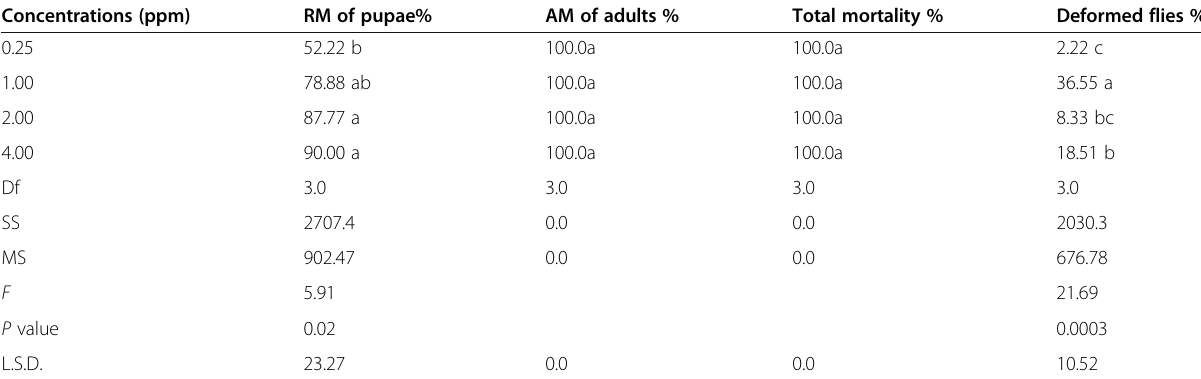
Table 2 The real and apparent mortalities, and deformed flies percentages of the peach fruit fly, Bactrocera zonata , treated with abamectin pesticide at pupal stage Concentrations (ppm)